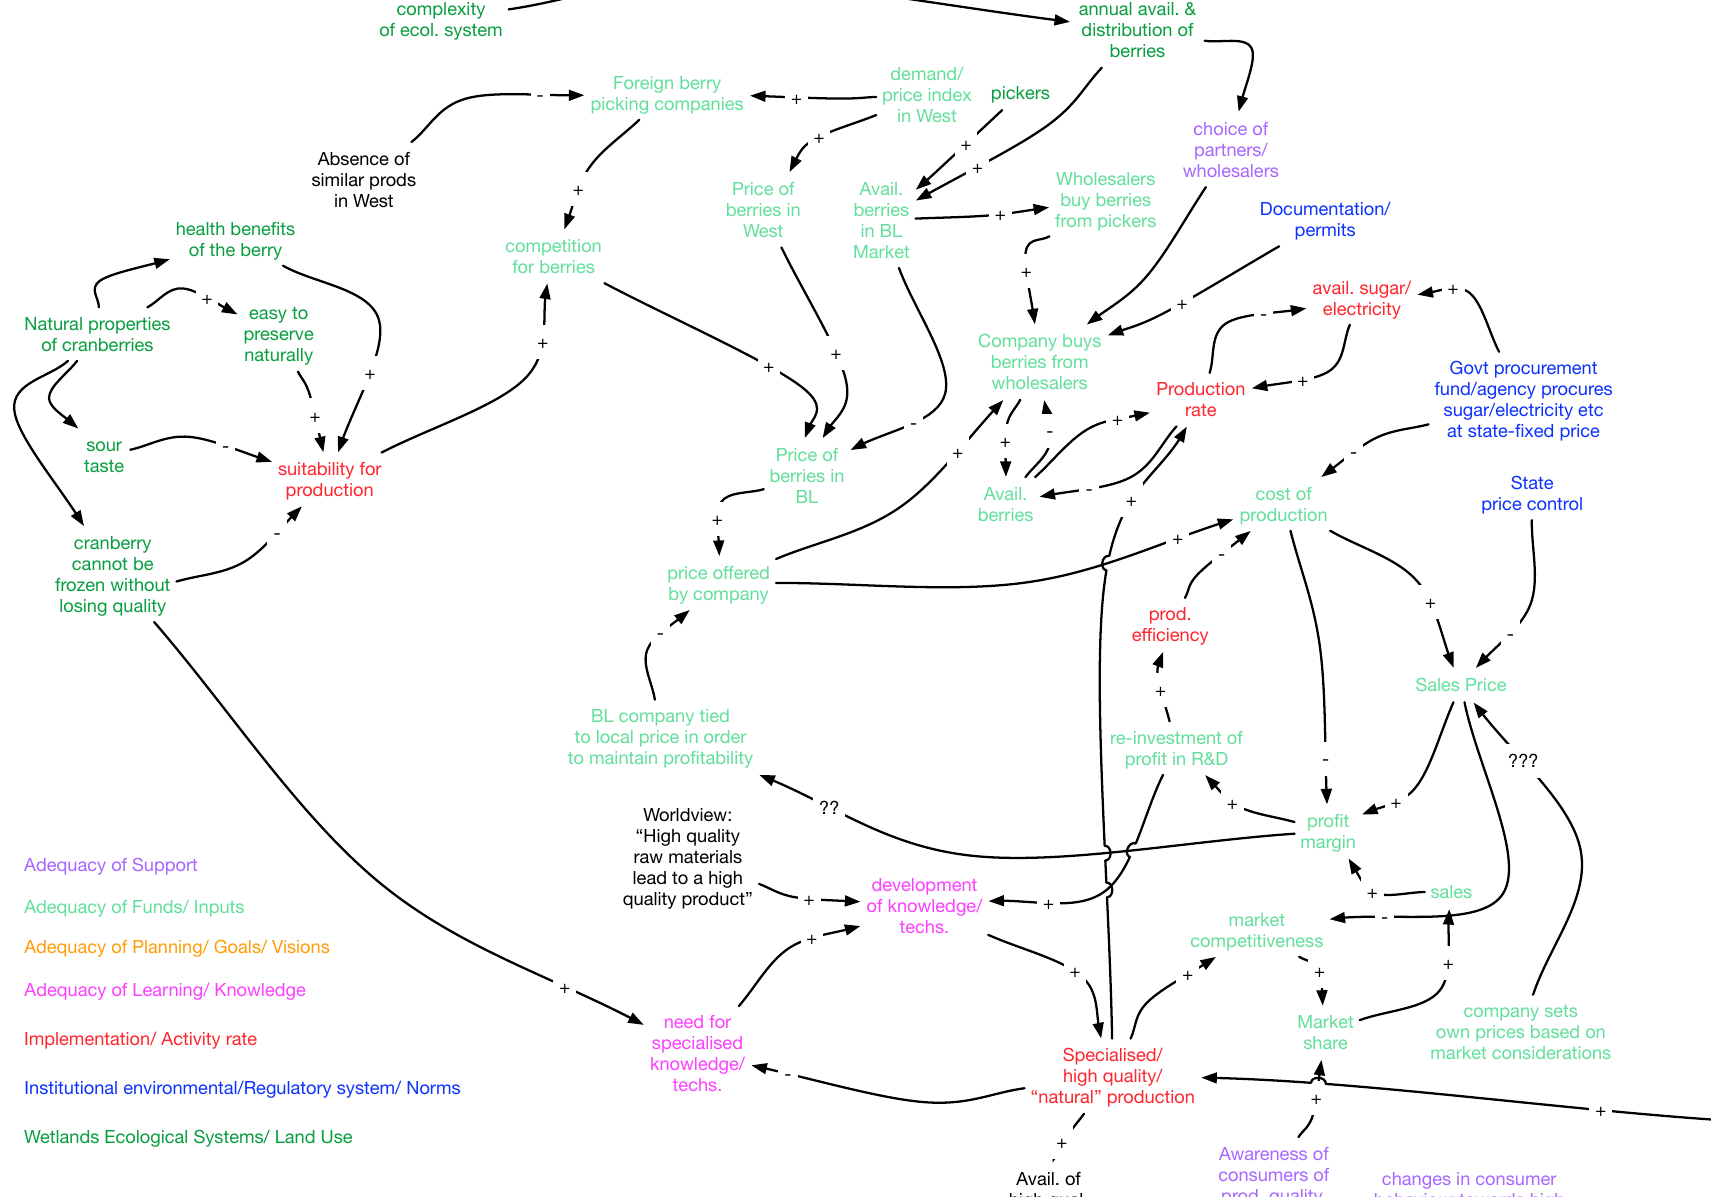
Figure A2:16. Case Berries, Theme: